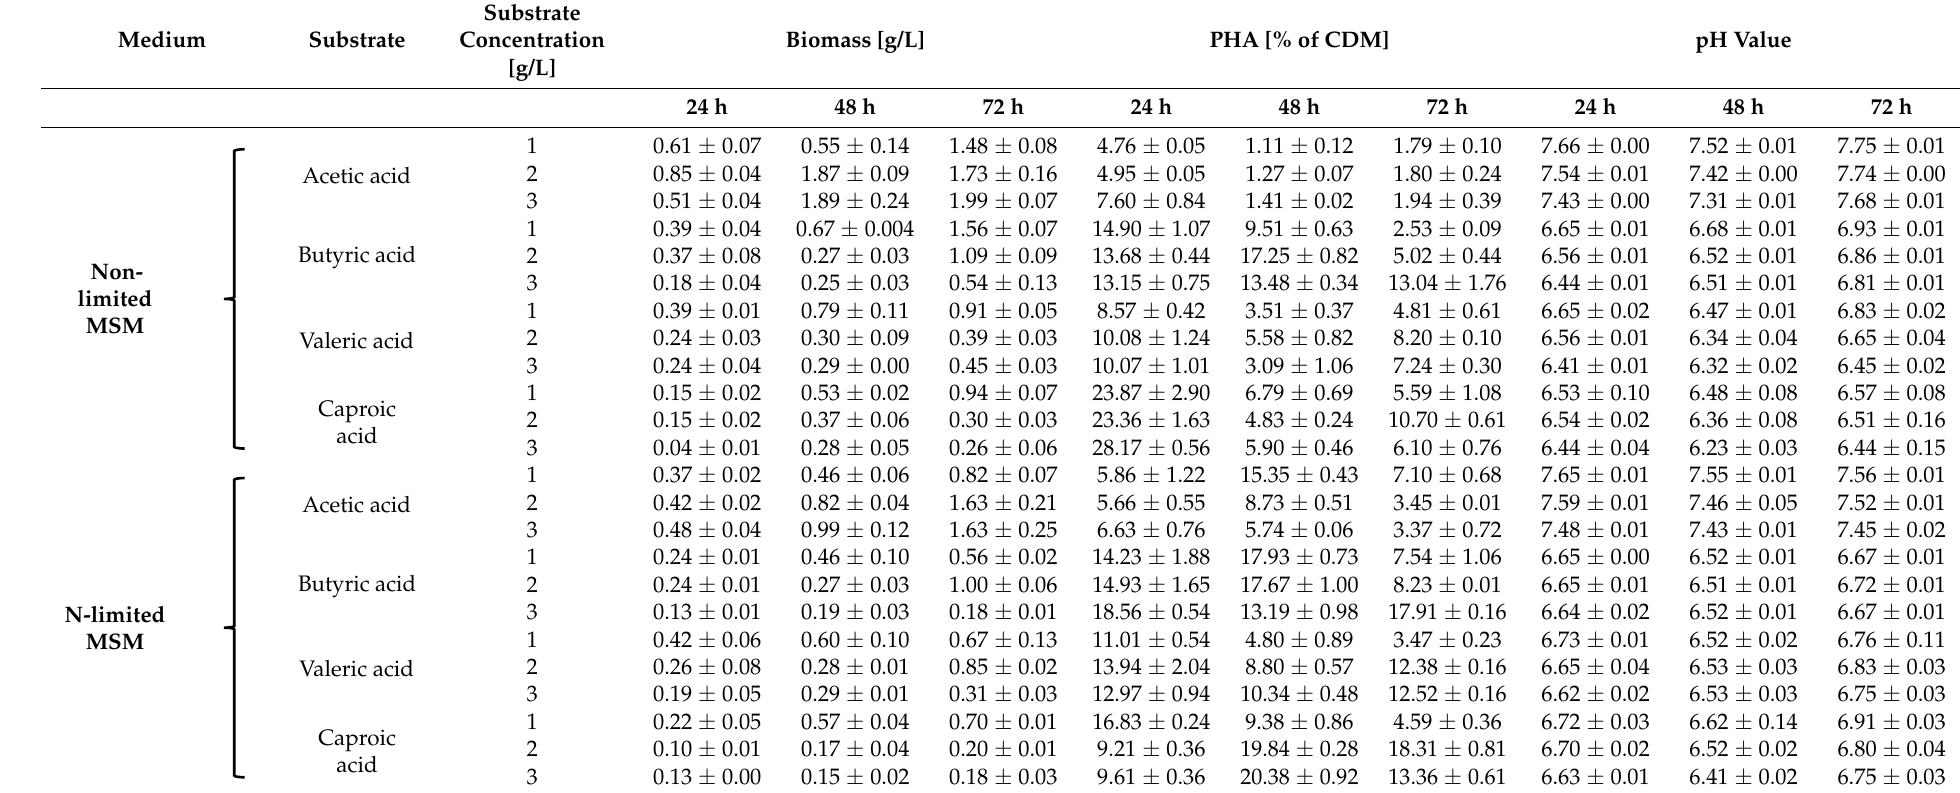
Table 2. Biomass concentration and PHA production from individual short and medium chain fatty acids by Aeromonas sp. AC_01.